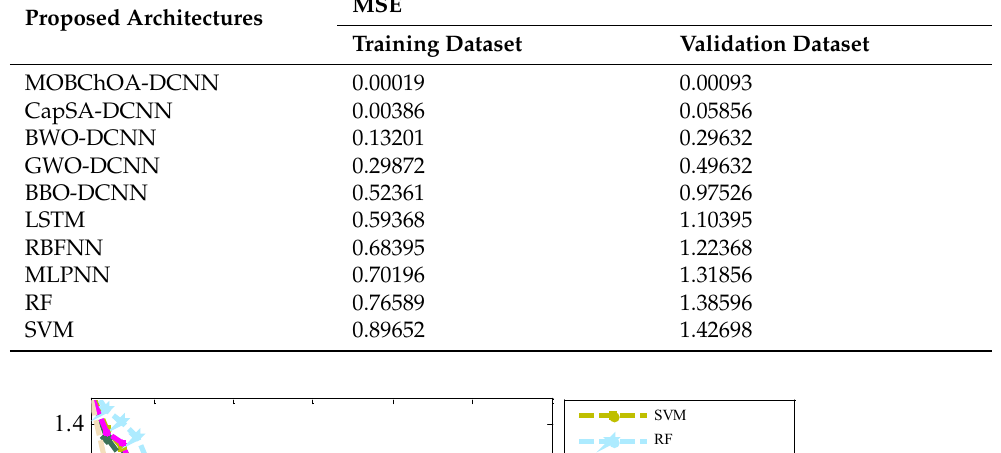
Table 7. Comparison of the algorithms according to MSE.